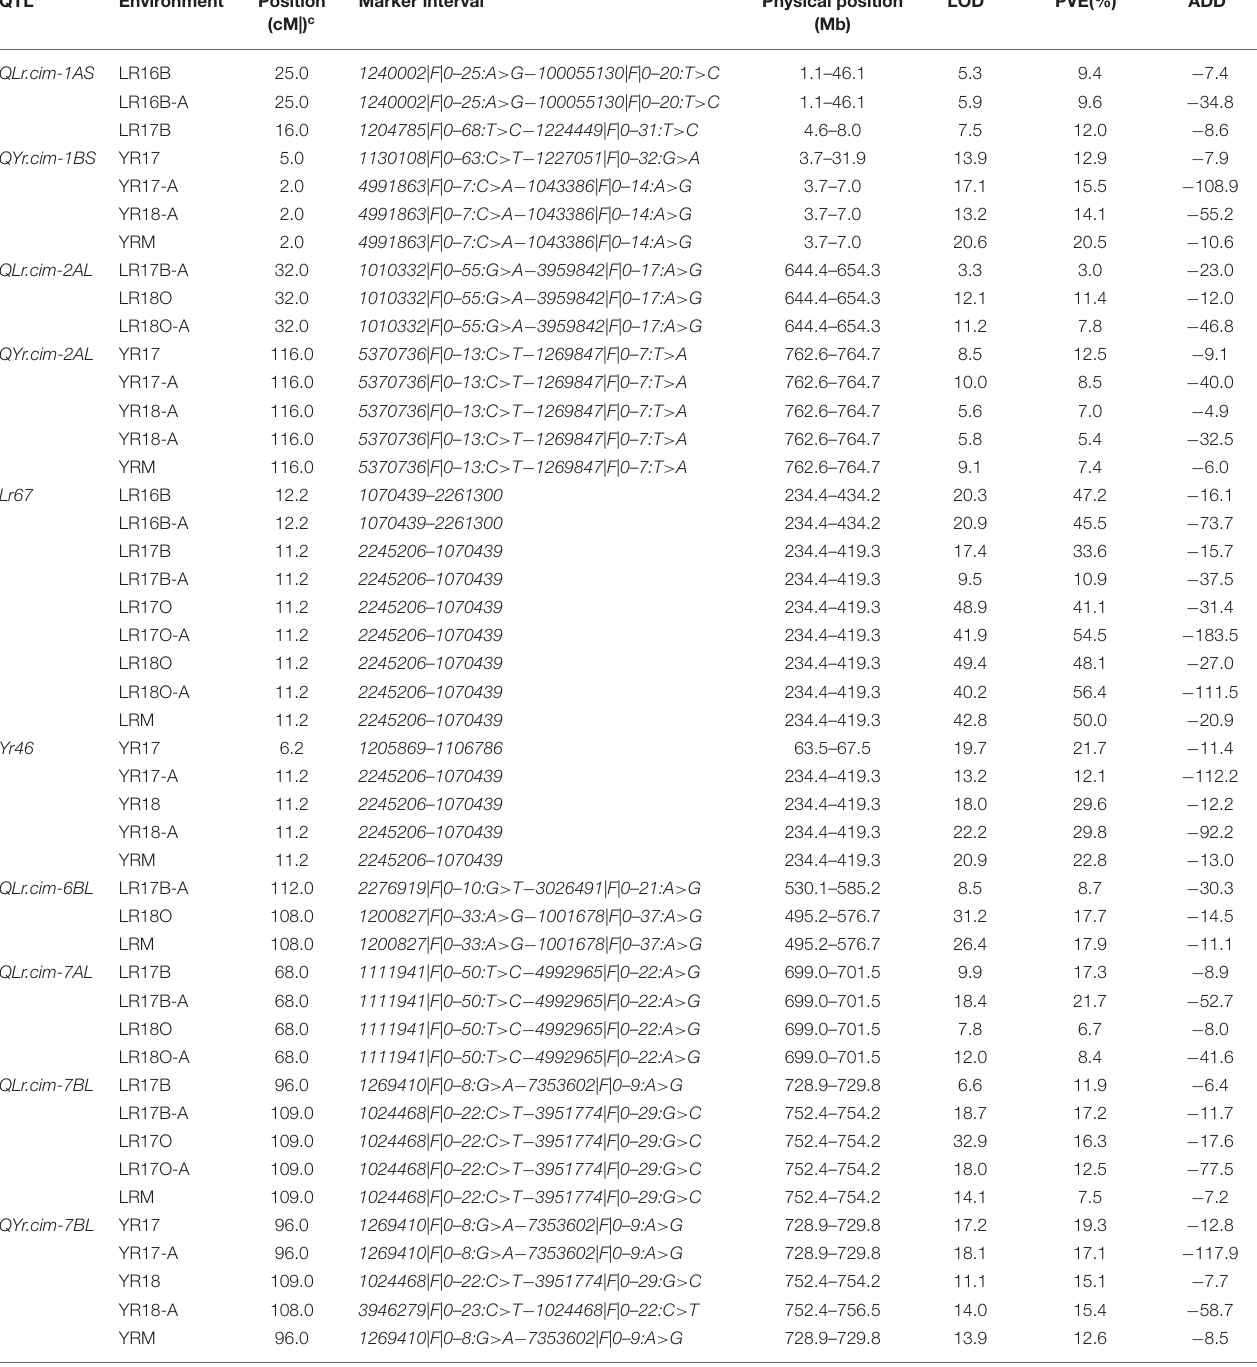
TABLE 4 | Quantitative trait locus/loci for MDS to leaf rust and stripe rust by ICIM in the BIL population from Ku3067/Apav. QTL